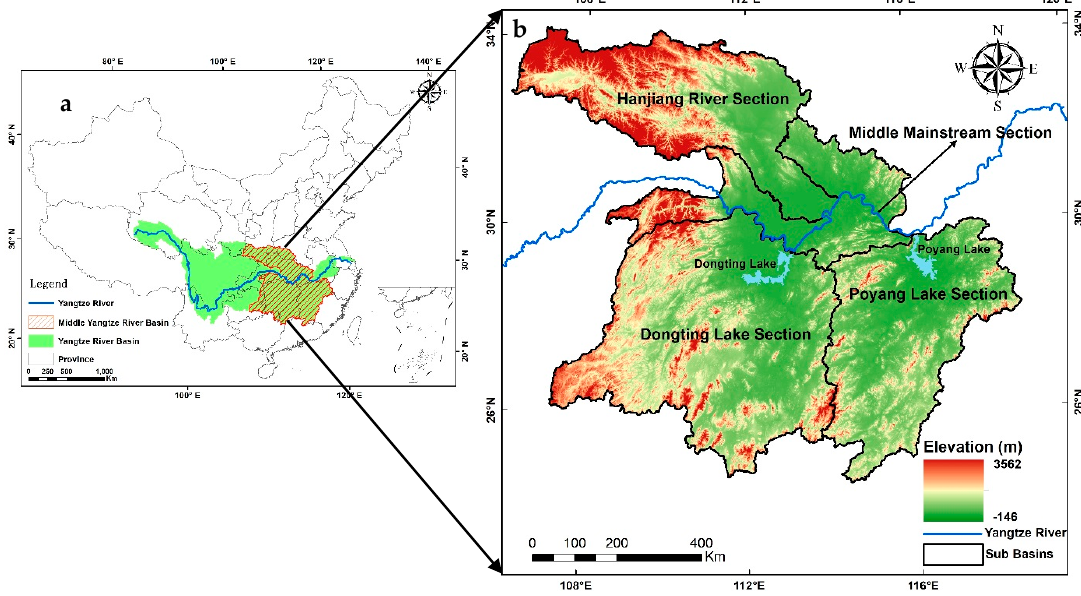
Figure 1. An overview of the Middle Yangtze River Basin (MYRB): ( a ) the location of the MYRB in China; ( b ) the topography and division of the study area.